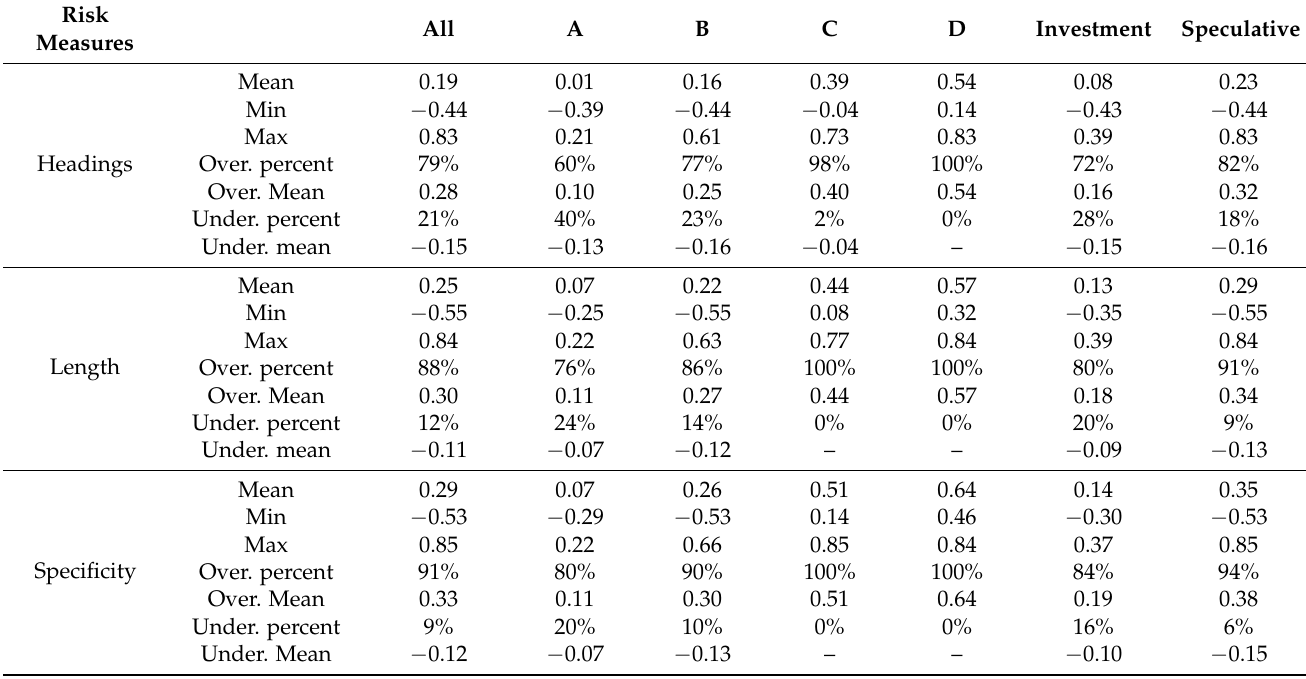
Table A1. Statistical results of bias of length, headings, and